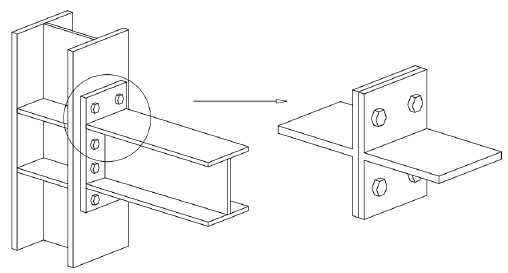
Figure 1. Diagram of the T-stub.